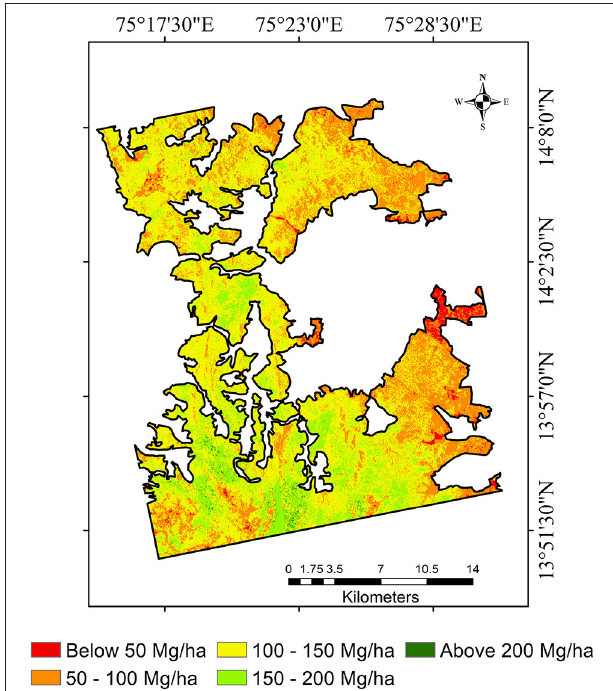
FIGURE 8 | Forest aboveground biomass map generated from the best performing RF model with predictor variables - L- γ 0 HH , L- γ 0 HV , C- γ 0 HV , and GEDI canopy